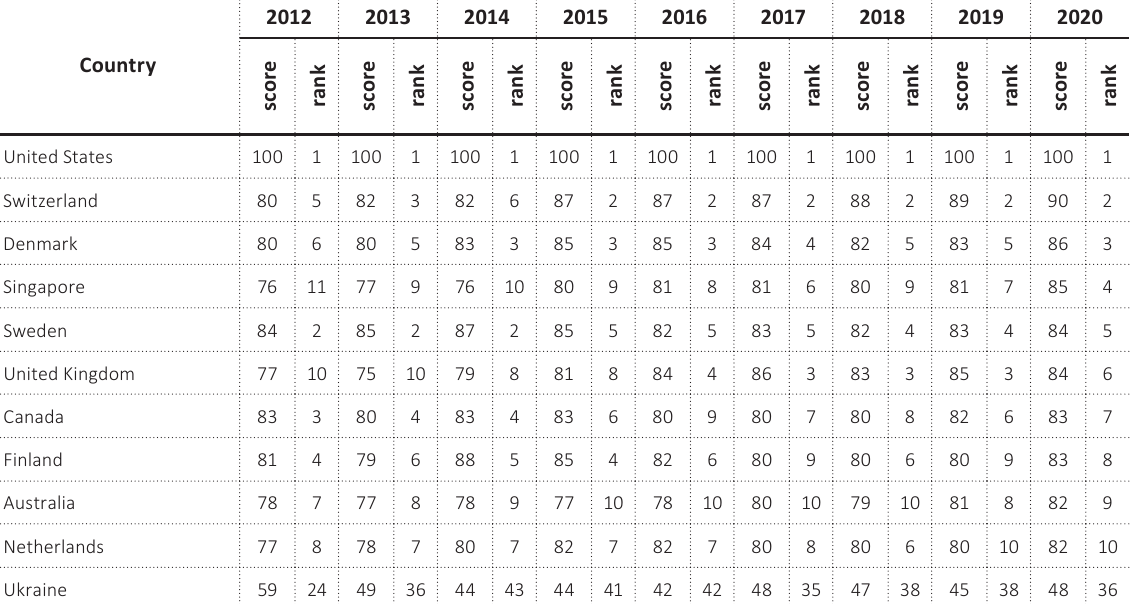
Source: Universitas 21